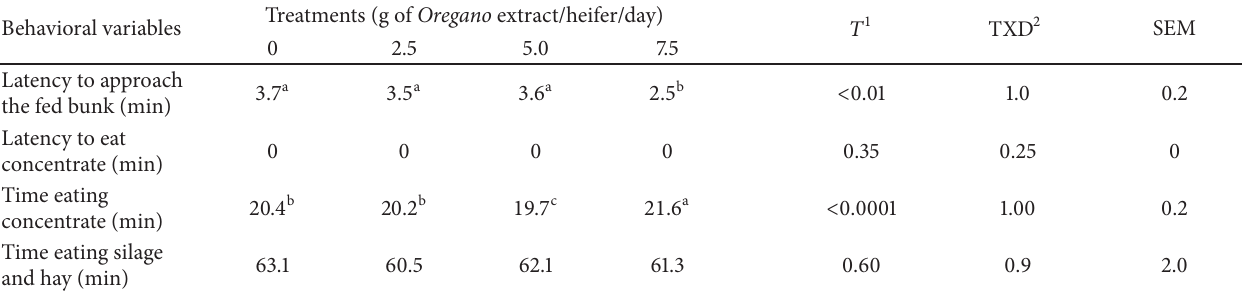
Table 4: Treatments significance level ( 𝑇 ), treatment × day interaction (TXD), and means of feeding behavior in the feed bunk. Behavioral